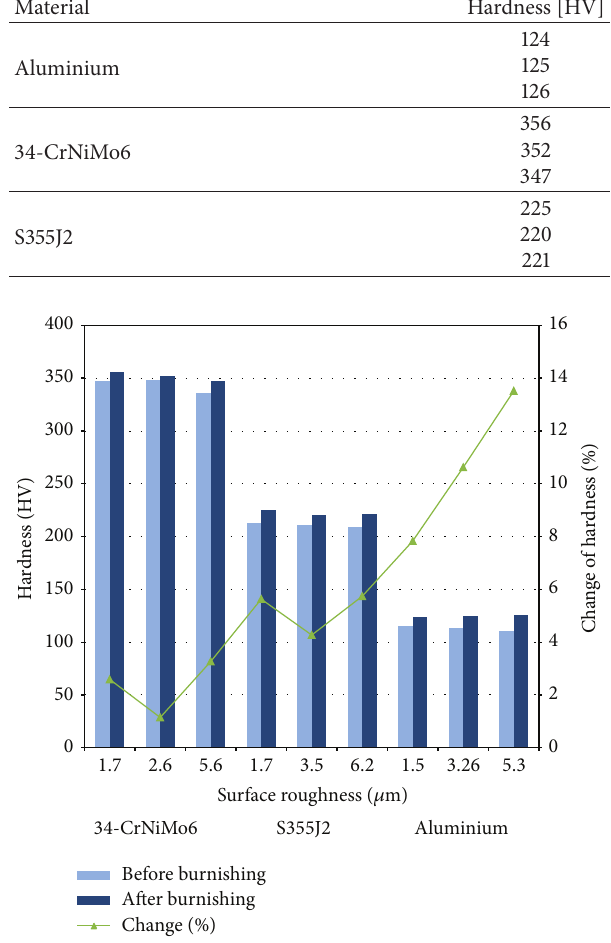
Figure 3: The hardness measurements of the workpieces before and after ultrasonic burnishing.